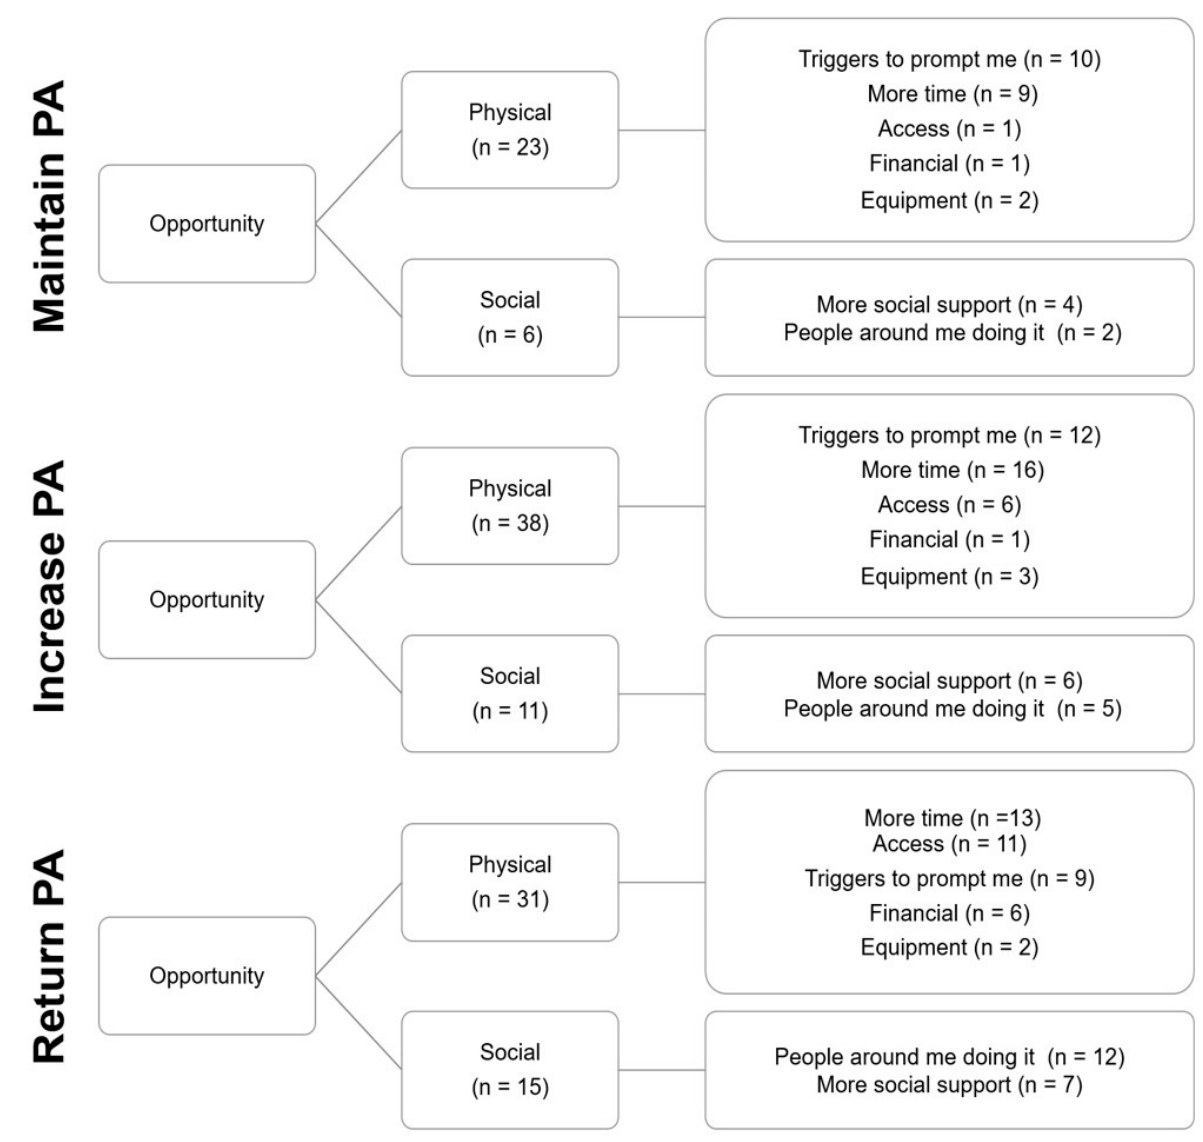
Figure 5. Perceived opportunity barriers grouped by intended PA target behaviour. The proportion of physical and psychological capability barriers did not differ between groups (Figure 4. X 2 (2, n = 218) = 0.317; p = 0.853; V = 0.38). Physical stamina and physical strength were the most regularly cited physical barriers. The percentage of participants that cited each physical capability barrier did not differ between groups (Figure 4. X 2 (6, n = 138) = 3.138; p = 0.791; V = 0.105). Specific psychological capability barriers were more varied between the groups, but were not statistically different (Figure 4. X 2 (10, n = 103) = 4.156; p = 0.940; V = 0.137). The proportion of cited Physical and Social opportunity barriers did not differ between groups (Figure 5. X 2 (2, n = 124) = 1.797, p = 0.407, V = 0.120). The proportion of participants that cited each specific physical (Figure 5. X 2 (8, n = 102) = 10.262, p = 0.247, V = 0.216) and social opportunity barrier did not differ between groups (Figure 5. X 2 (2, n = 36) = 0.309, p = 0.857, V = 0.093). The proportion of cited Reflective and Automatic motivation barriers did not differ between groups (Figure 6. X 2 (2, n = 203) = 1.448; p = 0.485; V = 0.084). Furthermore, the proportion of participants that cited each specific Reflective (Figure 5. X 2 (4, n = 113) =